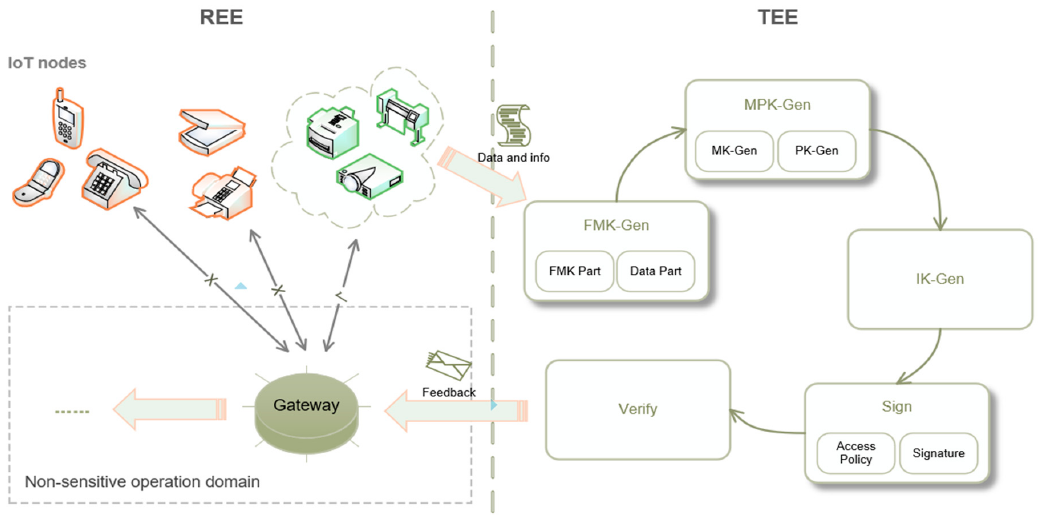
Figure 4. The dominant modules in a secure scheme.